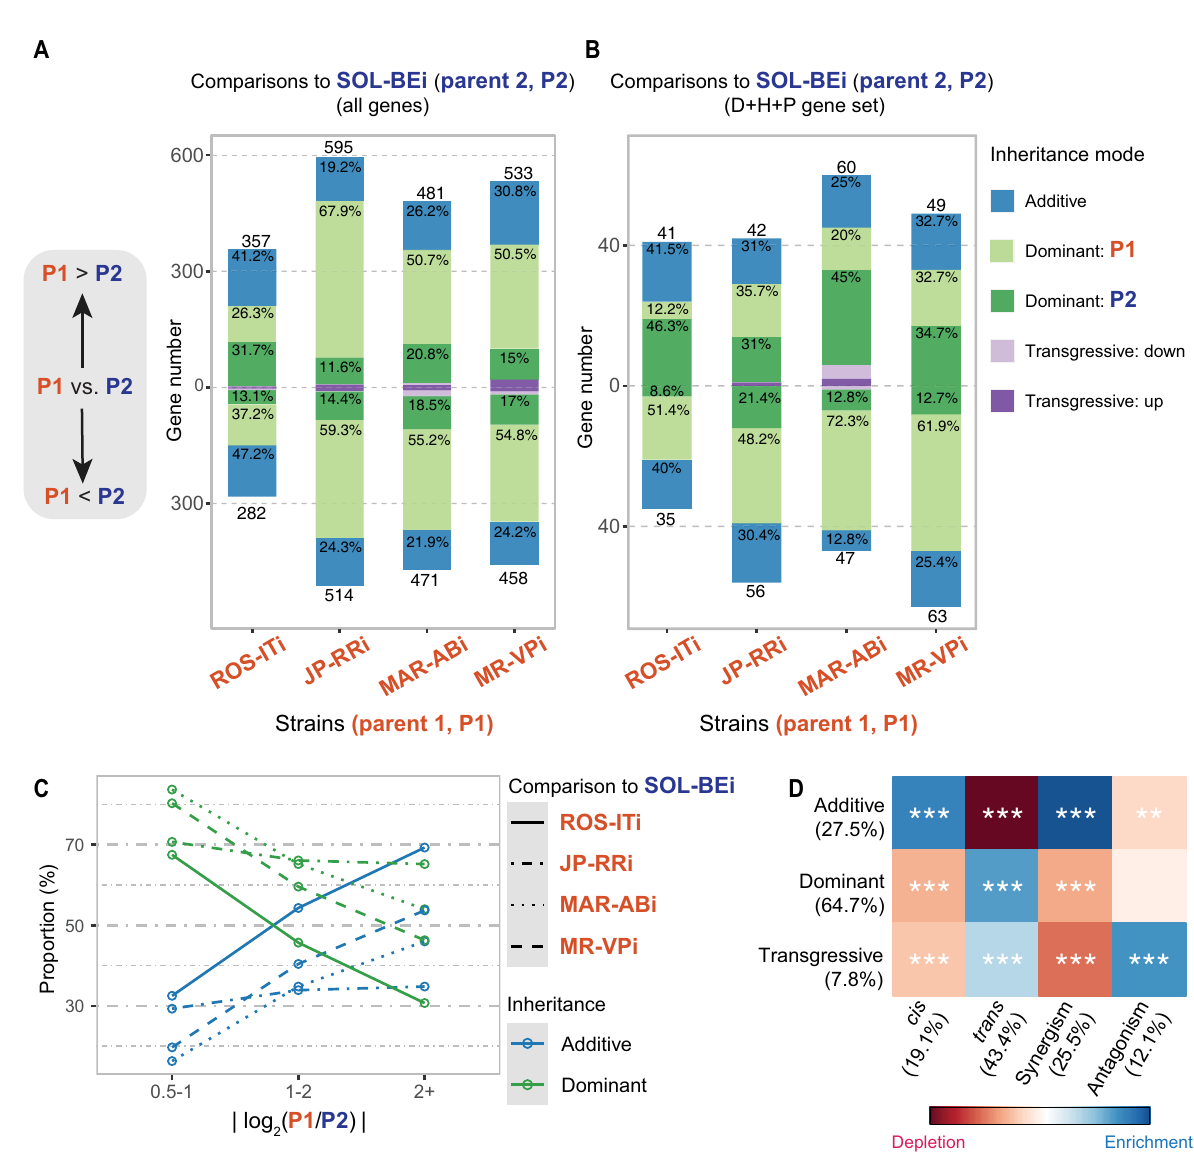
Fig 6. Inheritance of gene expression and its association with regulatory categories for gene expression variation. (A-B) Stacked barplots display the composition of each inheritance mode for comparisons of four strains (ROS-ITi, JP-RRi, MAR-ABi, and MR-VPi, indicated as P1, see labels at bottom) to a common parent (SOL-BEi, indicated as P2) for all genes (A) and for those in the detoxification/host/peptidase (D+H+P) gene set (B). The following inheritance classifications were made: ( i ) additive, where that of the F1 equals the average expression of the respective parents, ( ii ) dominant, where that of the F1 equals expression of one parent (the direction of dominance is as indicated in the legend at the far left), and ( iii ) transgressive, for which F1 values are outside the range of the parents (the direction of transgression is defined as either up or down with respect to the parental range). The number of genes (y-axis) for P1 > P2 (above 0) and P1 < P2 (below 0) are indicated above or below the bars in the plot, with coloring of stacked bars denoting inheritance classifications (see legend, far right; within the stacked bar plots, percentages are given for modes > 5%). In panels A and B, transgressive inheritance for which P1 = P2 (no expression difference between parents) is not indicated. (C) Line plot displaying the relative proportions of additive and dominant inheritance modes (y-axis) stratified by absolute values of log 2 fold change in comparisons between parents (| log 2 (P1/P2)|, x-axis). The different line types represent the four comparisons, and different colors denote additive or dominant modes (see legend at right). (D) The association between each combination of mode of genetic control ( cis , trans , synergism, and antagonism) and inheritance mode (additive, dominant, and transgressive). The significance of enrichment (blue) or depletion (red) is denoted using asterisks (chi-square tests of independence followed by Benjamini-Hochberg multiple test corrections; adjusted p < 0.05: � ; adjusted p < 0.01: �� ; adjusted p < 0.001: ��� ). The data upon which this figure is based are provided in S9